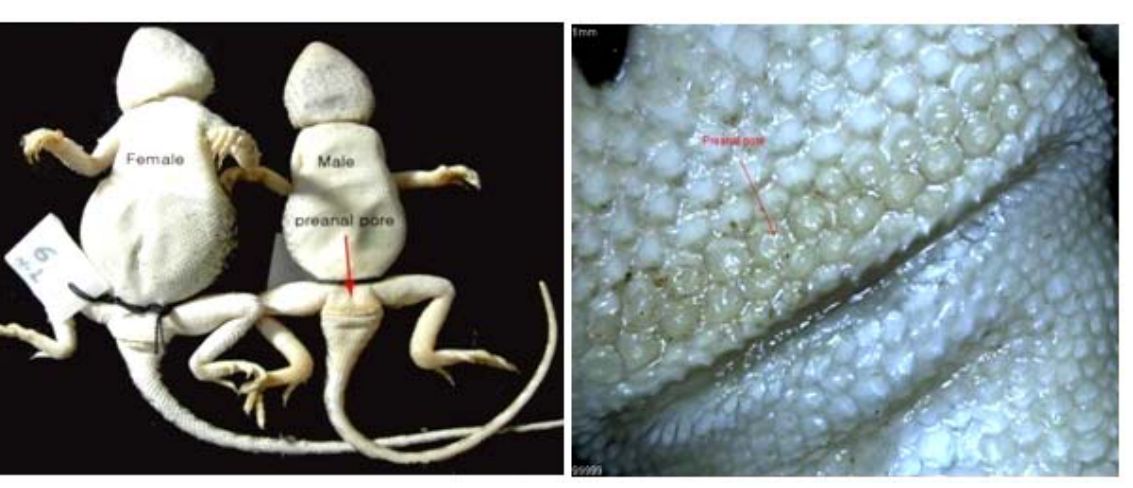
F IGURE 4. Morphological sexual dimorphism in the form of the anal region and pre-anal pores in T. lessonae : male (right), female